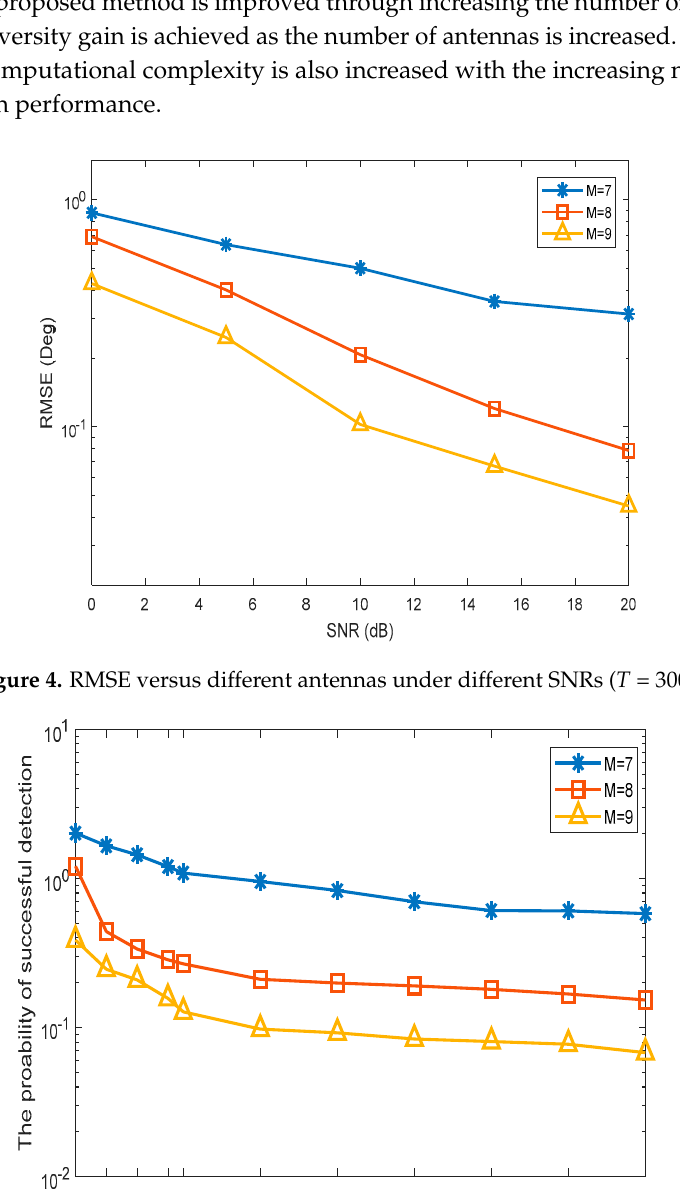
Figure 5. RMSE versus different antennas under different number of snapshots ( SNR 10 = dB).